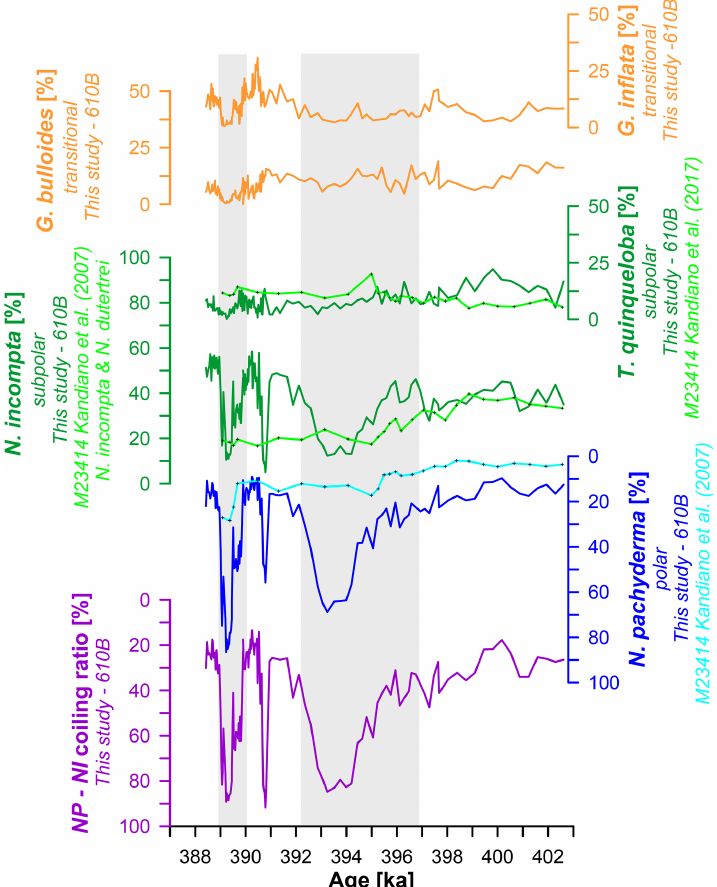
Figure 2. The evolution of planktic foraminifera over the MIS 11 glacial inception. From top-to-bottom, the relative abundances of G. inflata (transitional, orange), G. bulloides (transitional, orange), T. quinqueloba (subpolar, green), N. incompta (subpolar, green), and N. pachyderma (note reversed axis, polar, blue) and the coiling ratio (%) of N. pachyderma to N. incompta (note reversed axis, purple). Also shown are assemblage counts for T. quinqueloba , N. incompta , and N. pachyderma from nearby site M23414 (Kandiano and Bauch,